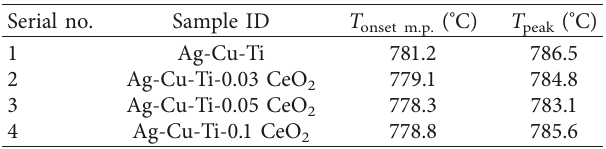
Figure 7: Melting point behavior of various Ag-Cu-Ti- x CeO Table 3: Various temperatures obtained from the melting curve of fillers. Serial